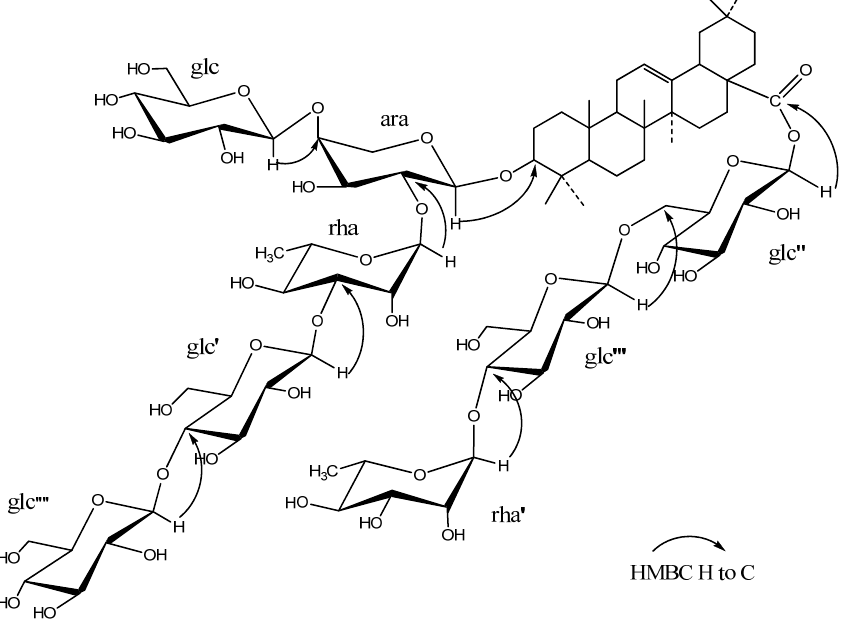
Figure 2. Key HMBC correlations (from H to C) of compound 1